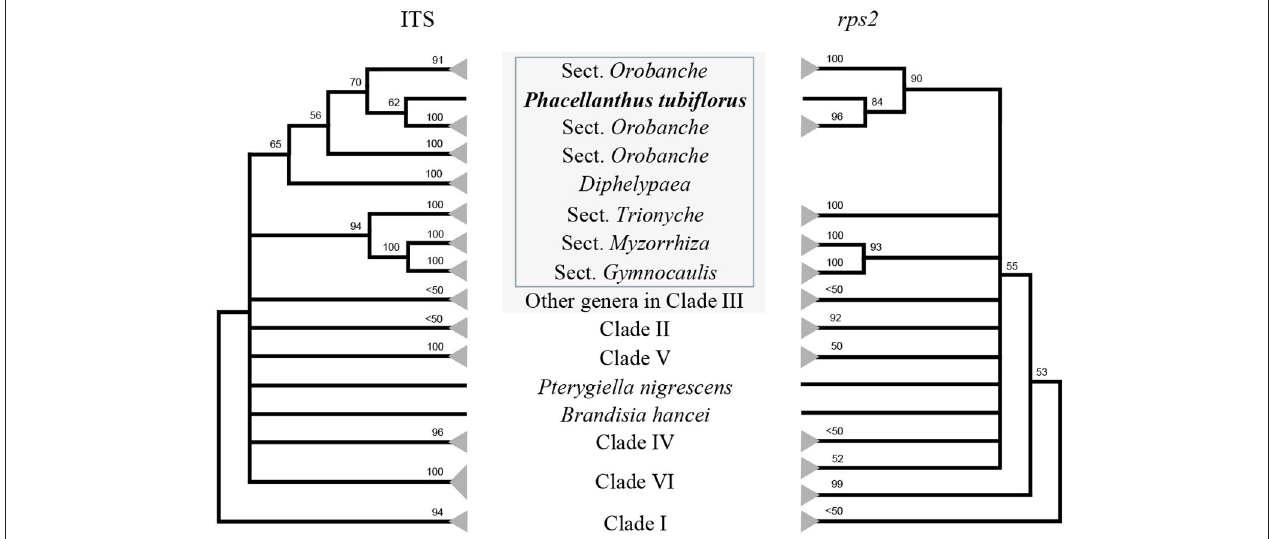
FIGURE 1 | Schematic maximum likelihood phylogenetic trees based on the sequences of ITS (left) and rps2 (right) showing the evidence that Phacellanthus tubiflorus is nested in the section Orobanche of the genus Orobanche . Numbers above branches are bootstrap values, only bootstrap values > 50 are shown. Taxa in gray shadow represent Clade III = Orobancheae. Four sections of Orobanche and Diphelypaea are indicated in the box. The expanded trees are presented in Figures S7 – S10 .